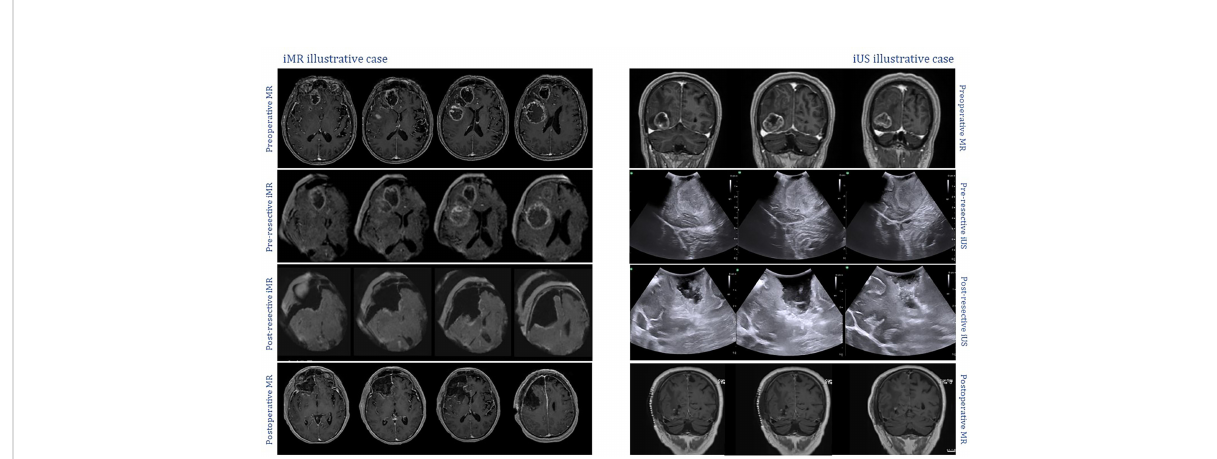
FIGURE 3 Intraoperative captures displaying examples of the imaging techniques undertaken during the study. Left , low- fi eld iMR illustrative case. All images correspond to axial sections of T1 sequences after gadolinium administration. On the top row, preoperative MR study showing a right frontal lesion corresponding to a high-grade glioma; on the second row, initial iMR acquisition; on the third row, iMR control image obtained after resection, no residual disease can be seen around the surgical cavity; on the last row, postoperative MR con fi rming complete resection of the tumor. Right , iUS illustrative case. On the top row, preoperative MR T1+gadolinium coronal sections showing a right occipital high-grade lesion; on the second row, initial iUS exploration with a coronal view of the occipital lesion adjacent to the tentorium cerebelli; on the third row, iUS control exploration after surgical resection, with no apparent residual disease; on the last row, postoperative MR T1+gadolinium con fi rming complete resection of the